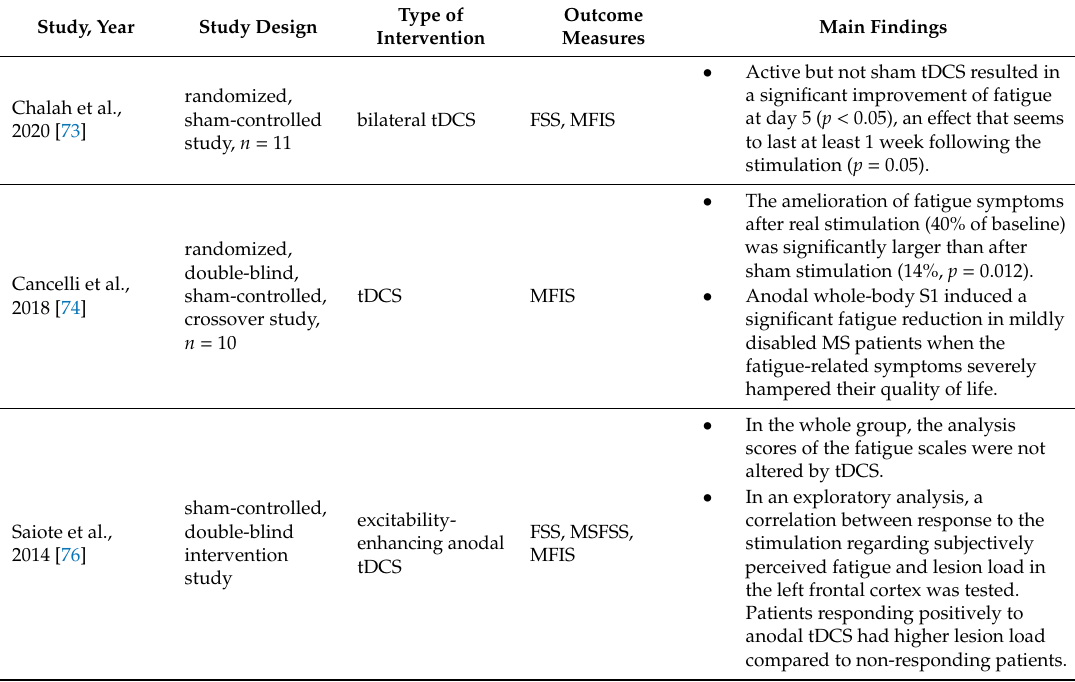
Table 6. Clinical studies of non-invasive brain stimulation in patients with MS-related fatigue. Study,